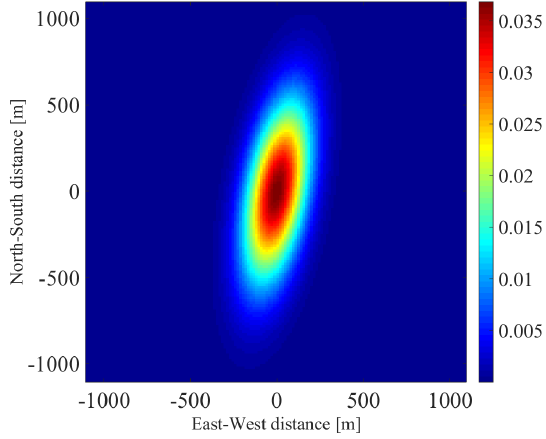
Figure 9. Probability density function for hydraulic connections P as defined in Eq.